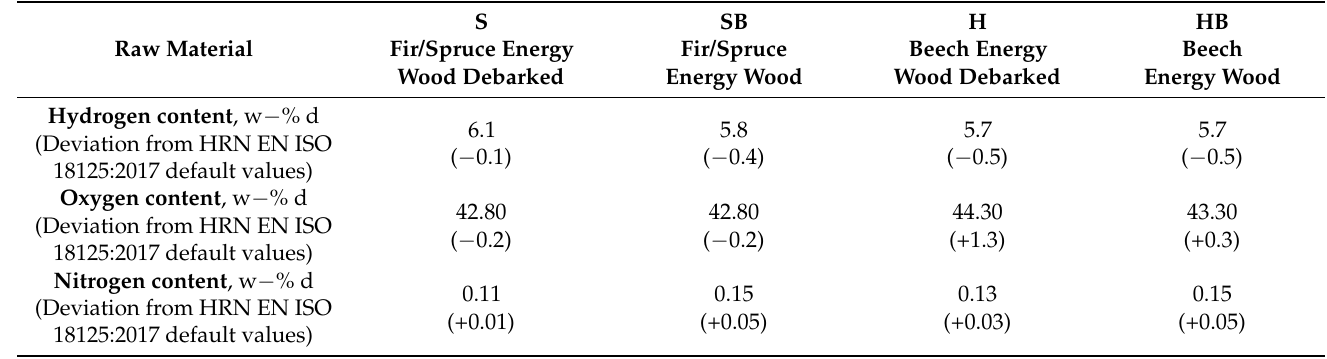
Table A1. Results of the CHN(S) analyses.